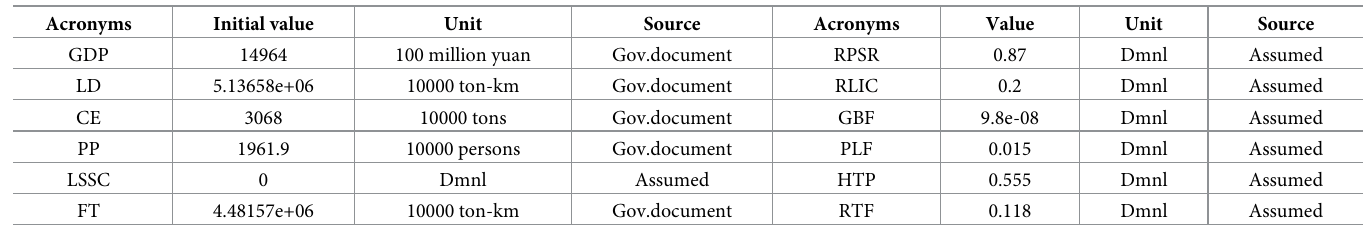
Table 5. Values of main factors in the